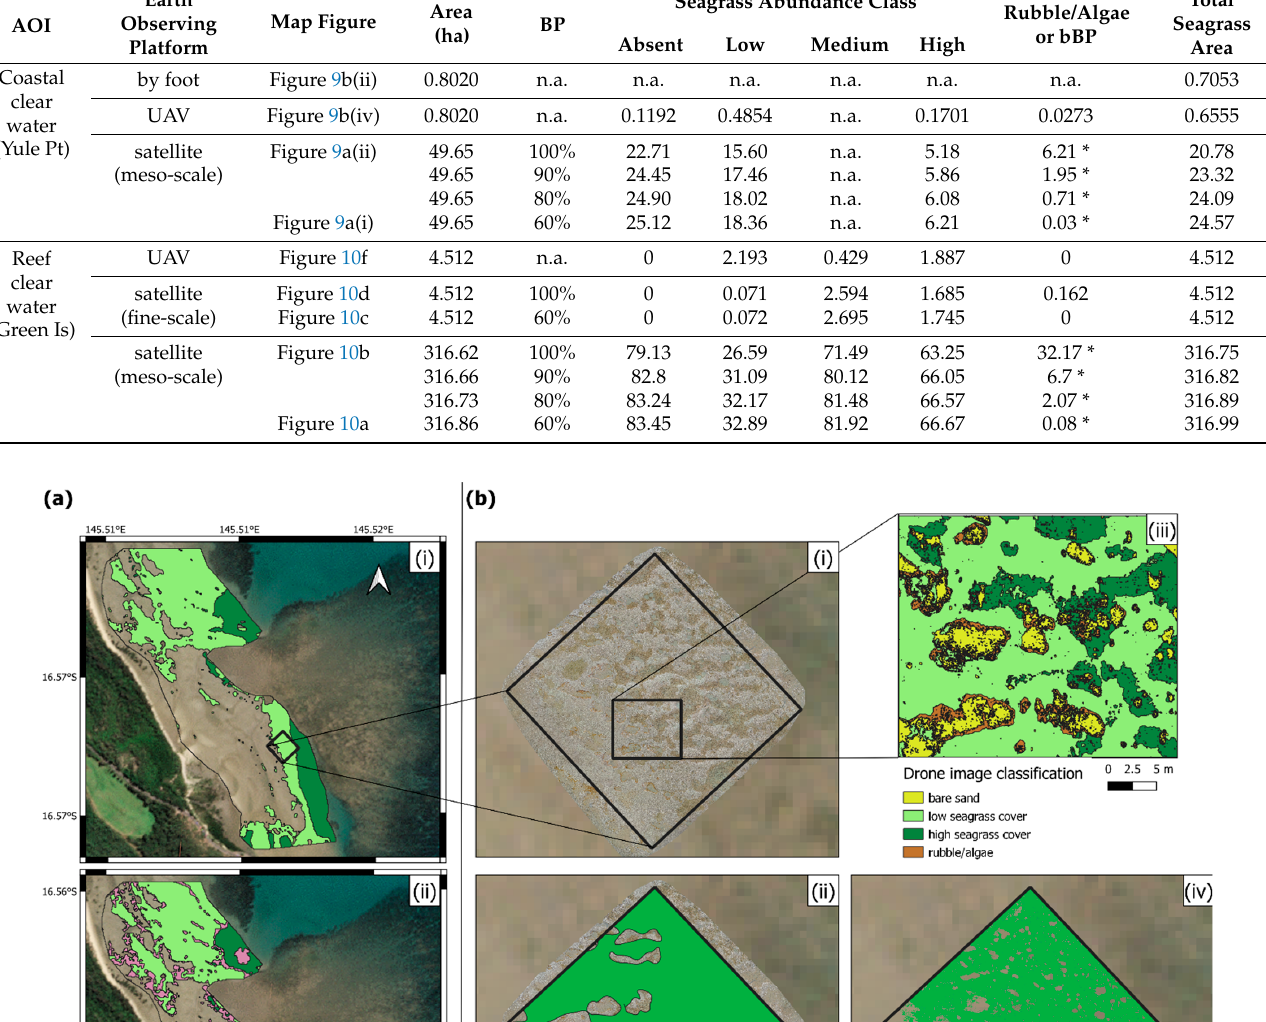
and 94.70 ± 0.01, respectively (Table S3). The area of seagrass for each abundance class was calculated at each level of probability, and the respective areas for probabilities be ‐ tween 90 and 60% were relatively similar (Table 7), indicating that the most conservative values representing mapping accuracy would be the bootstrap probabilities of 60 and 100% (Figure 10).